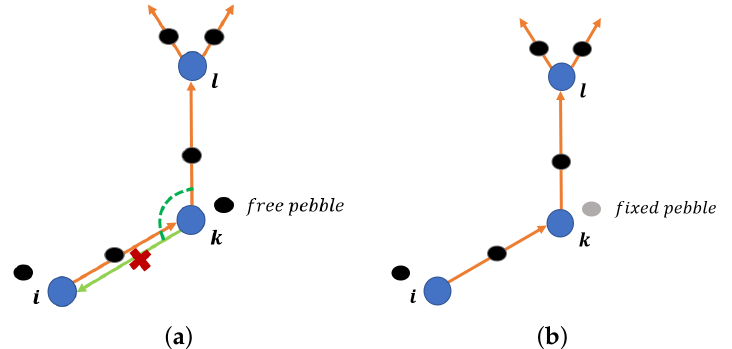
Figure 2. A scenario of the existence of the fixed pebble. ( a ) Existing directed graph before pebble searching operation. ( b ) A fixed pebble is recorded after searching operation.